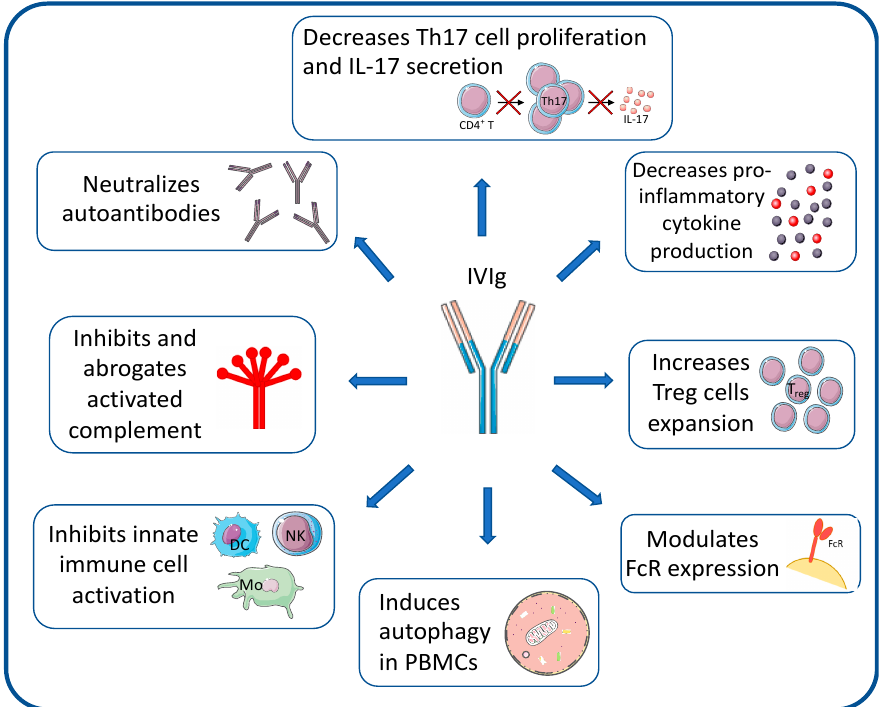
Figure 2. Immunomodulating effects of IVIg. Abbreviations: DC, dendritic cells; FcR, fragment crystallizable receptor; Mo, macrophages; NK, natural killer; PBMCs, peripheral blood mononuclear cells.